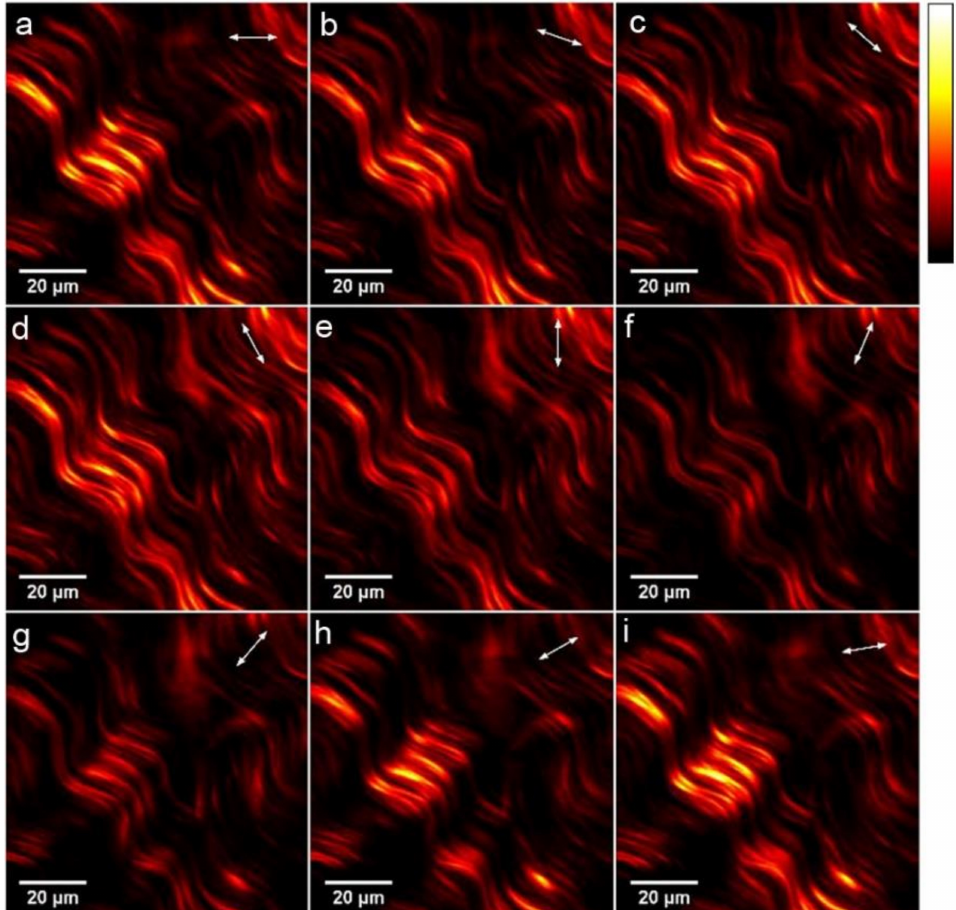
Figure 2. Polarization-dependent 2D SHG measurements recorded from an equine pericardium tissue. Nine out of the eighteen PSHG dataset images are shown. Every image ( a – i ) corresponds to the different linear polarization of the incident laser beam to the sample plane, indicated by the white arrow. The calibration bar denotes the maximum (white) and minimum (black) SHG intensity signals. In all cases, the scanning region was limited to 90 µ m × 90 µ m. The number of pixels